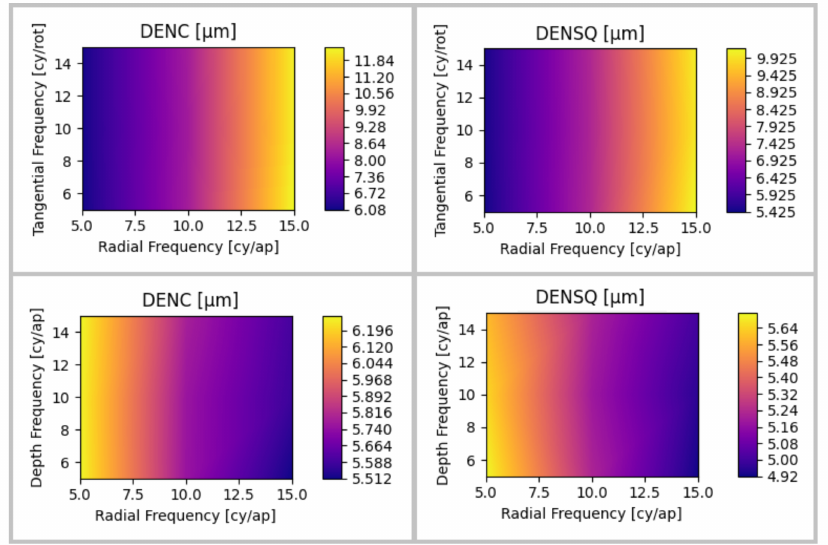
Figure 10. Example of in-plane & out-of-plane TM independence of seed frequency. Along a given vertical cross-section, the DENC/DENSQ metrics remains relatively constant. This demonstrates the independence on tangential frequency. In-Plane Parameters: ( η = ζ = δ = 0, κ = 0.15, σ = 0.05, AOI = 15 ◦ , f/2), Out-of-plane Parameters: ( κ = ω = δ = 0, η = 0.15, σ = 0.05, AOI = 15 ◦ , f/2).